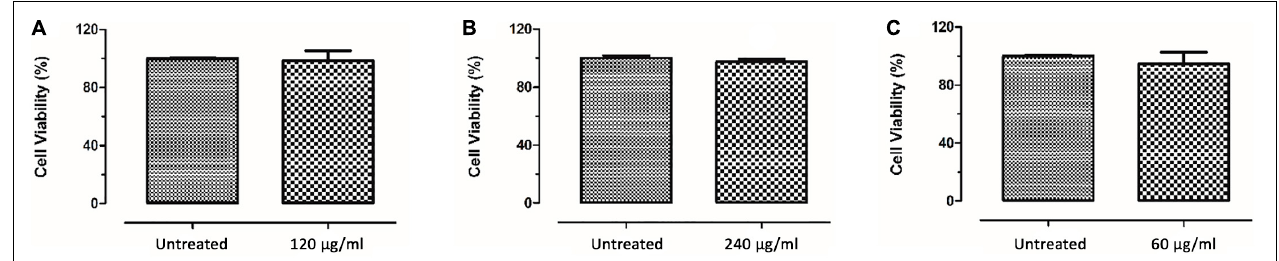
FIGURE 6 | HaCaT cell viability results after incubation with CFSE (A,B) and trans- 4-(2-carboxy-vinyl) benzoic acid (C) for 24 h.